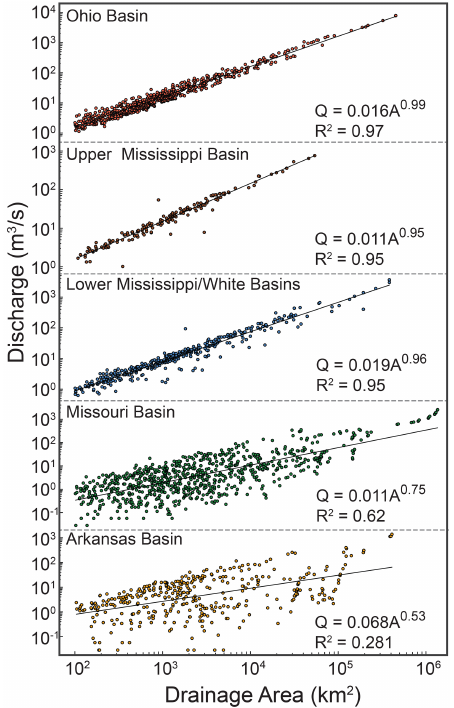
Figure 4. Discharge–drainage area relationships for sub-basins of the Mississippi; exponents close to 1 indicate a nearly linear fit in the Ohio, Upper and Lower Mississippi sub-basins, but there is substantial deviation from unity in the Missouri and Arkansas sub-